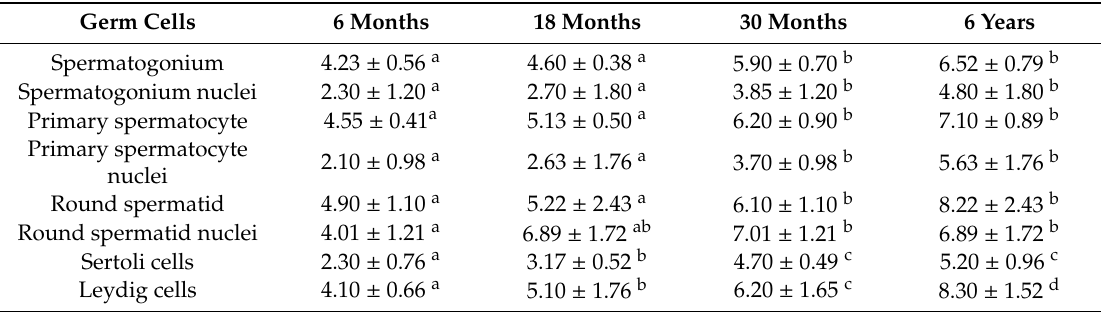
Table 2. Diameters ( µ m) of spermatogenic cells and their nuclei in the testis of yak (mean ± standard error of the mean (SEM).